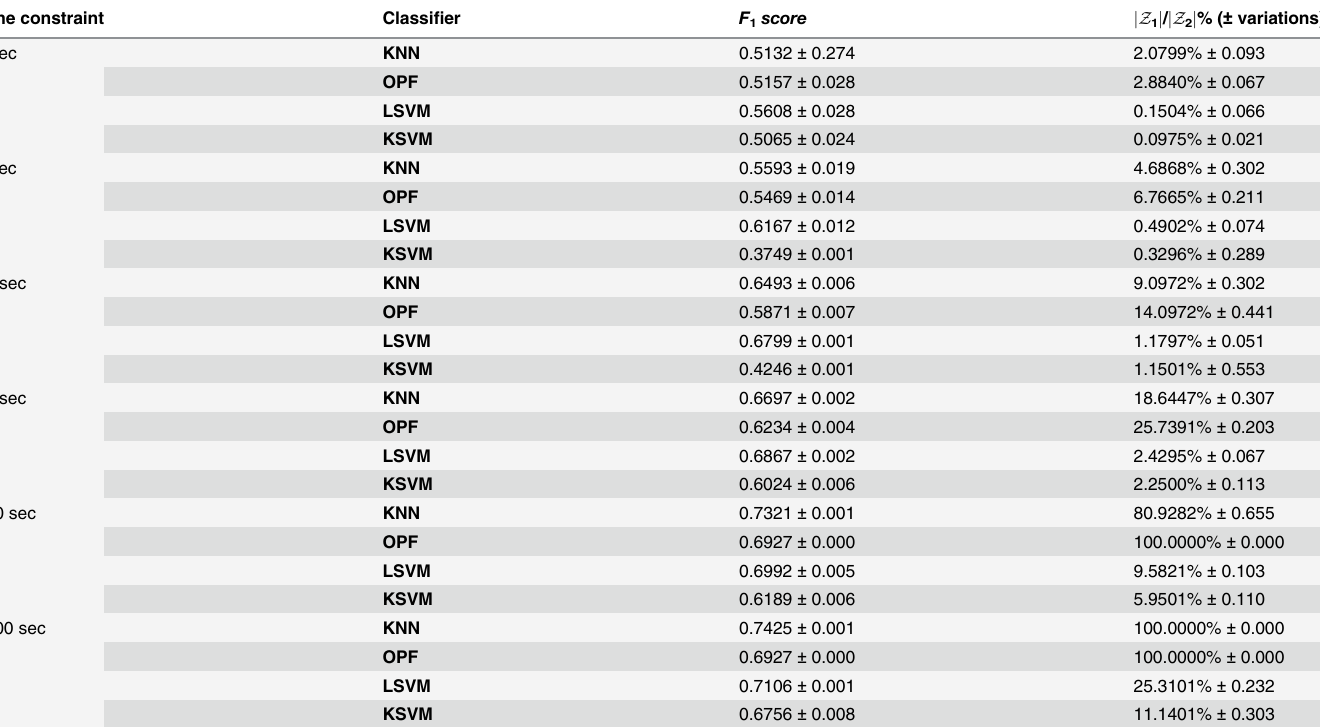
Table 8. Connect dataset: Predictivity performance over Z 3 and final training set size, j Z 1 j as a percentual of j Z 2 j , for each classification model and learning time constraint using random